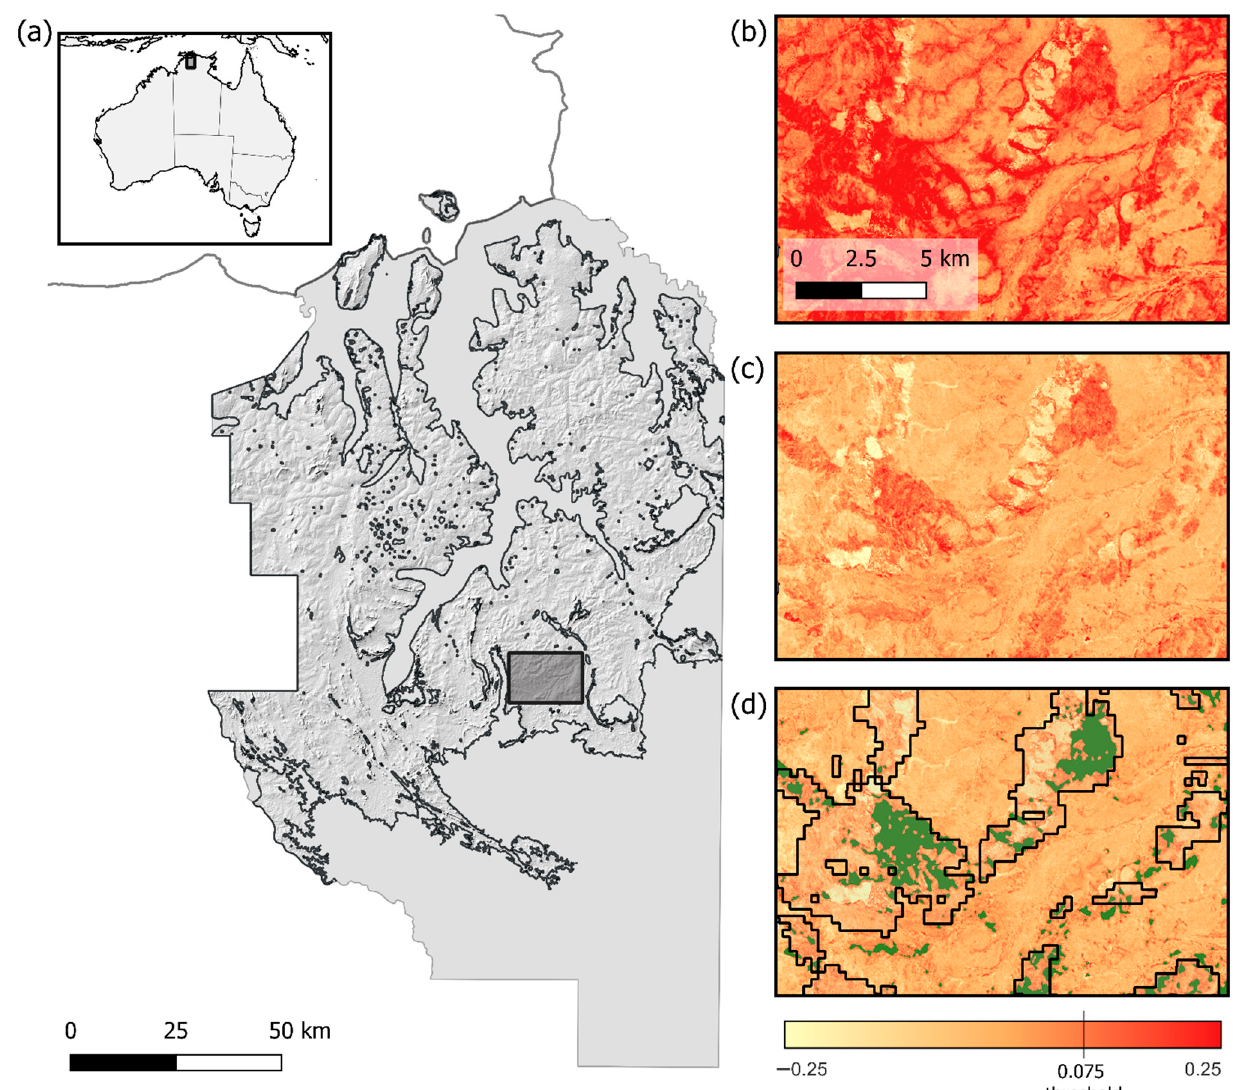
Figure 2. ( a ) Lowland Eucalyptus savanna within Kakadu National Park within black outline, with subset study region highlighted in red rectangle; ( b ) raw dNBR values for subset area for 2021; ( c ) double-dNBR for area, showing reduced contrast for permanent landscape features such as valleys and water courses; ( d ) Landsat burned area classification patches (green) compared to MODIS burned area outlines (black). Colour scale indicates values for both raw dNBR and double-dNBR, with the classification threshold value indicated.